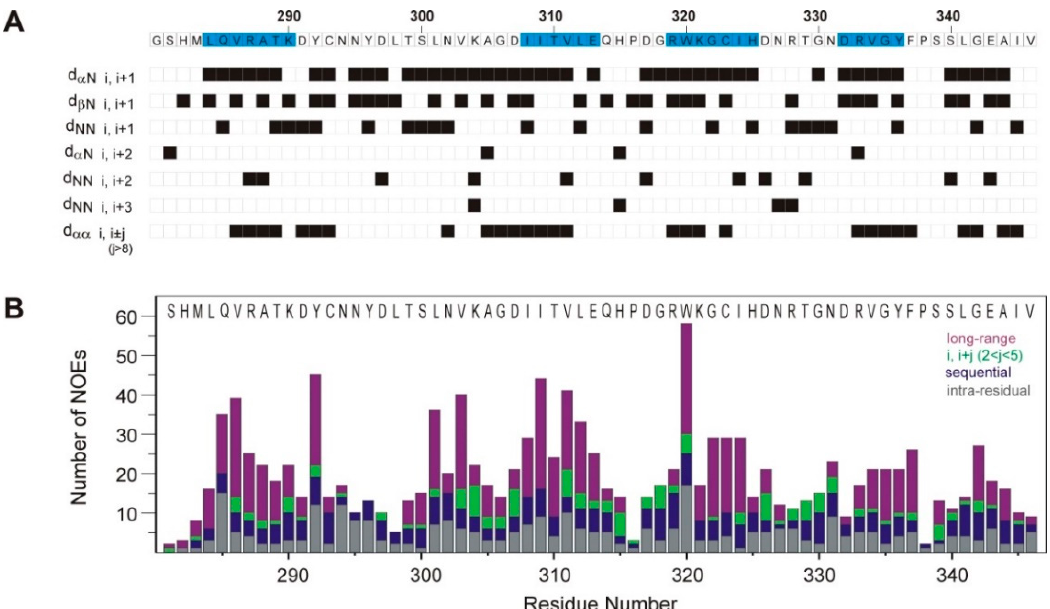
Figure 2. Summary of NMR structural parameters. ( A ) NOEs observed between residue pairs i and i + j are indicated in black. In the last row, NOEs between the alpha protons of residues separated by more than eight amino acids are diagnostic markers of strand-strand interactions in beta-sheets. The amino acid sequence of Caskin1 SH3 is shown at the top using the numbering of the complete human Caskin1 sequence. Residues with a consensus chemical shift index (CSI) indicating a beta-strand conformation as obtained from the analysis of the deviation of H α , C α , and C β chemical shifts from random coil values are highlighted in blue. No 3 10 helix is observed toward the C-terminus. ( B ) Distribution of NOE restraints. Intra-residue NOEs are in grey, sequential NOEs are in blue, NOEs between residues i and i + j, where 2 < j < 5 are in green, and long-range NOEs are in magenta.